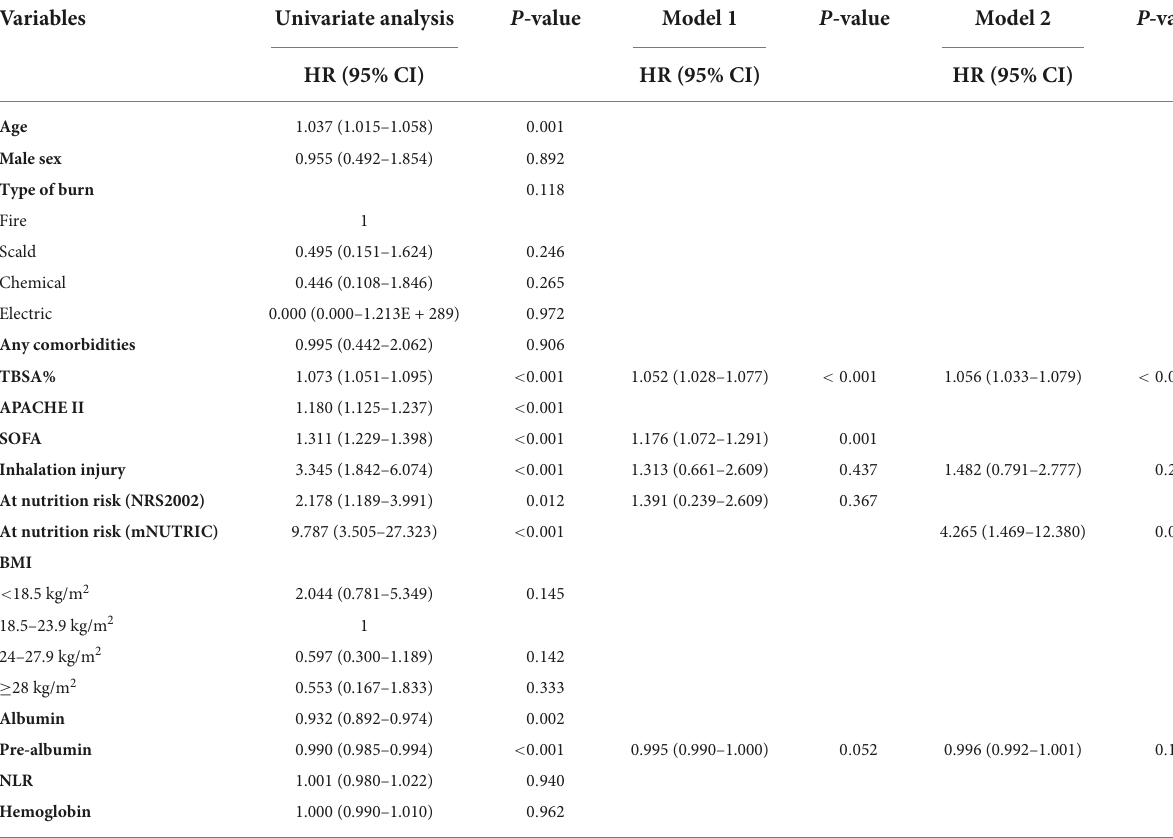
Variables Univariate analysis P -value Model